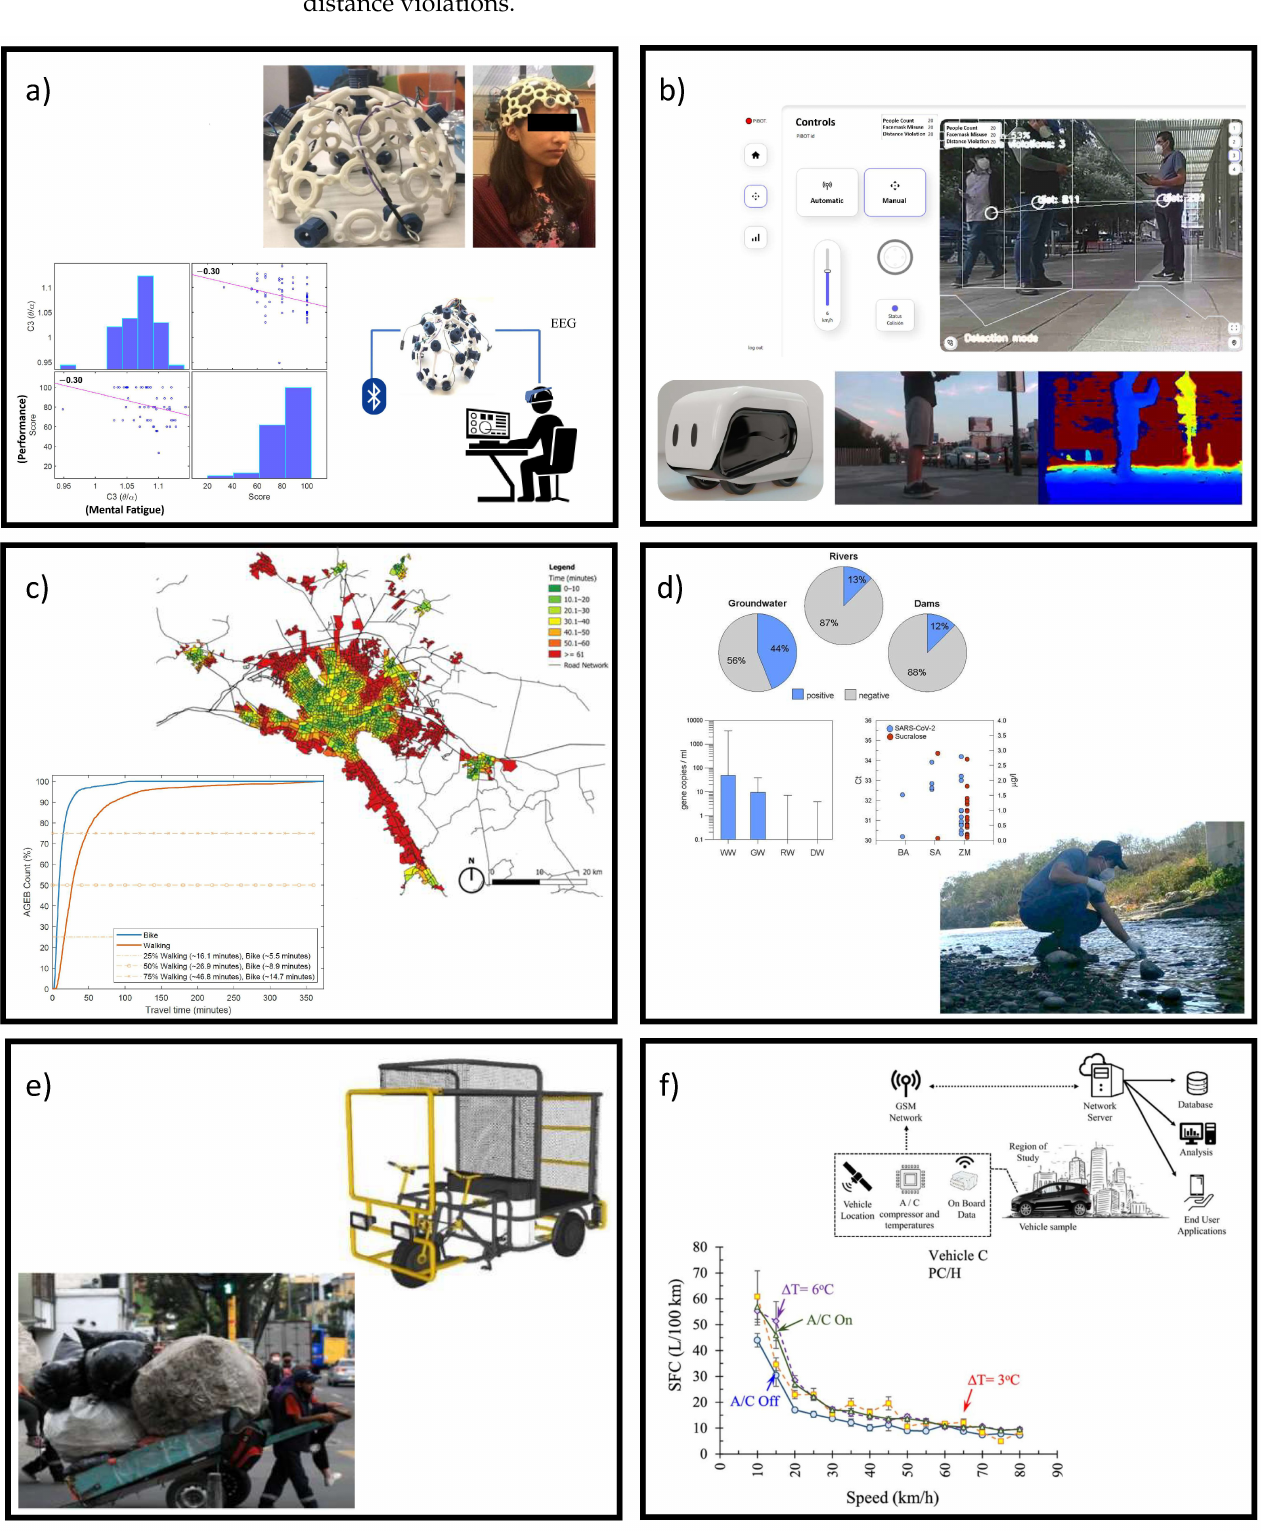
Figure 10. Study cases of smart cities implementations in Tecnologico de Monterrey, ( a ) Health: EEG monitoring for educational services; ( b ) Security: Space monitoring in the context of COVID-19 pandemic; ( c ) Mobility: Urban accessibility analysis in Monterrey City; ( d ) Water: Detection of SARS-CoV-2 RNA in freshwater environments from Monterrey City; ( e ) Waste: GPS monitoring and app for recycling vehicles; ( f ) Energy: Impact of A/C usage on light-duty vehicle’s fuel